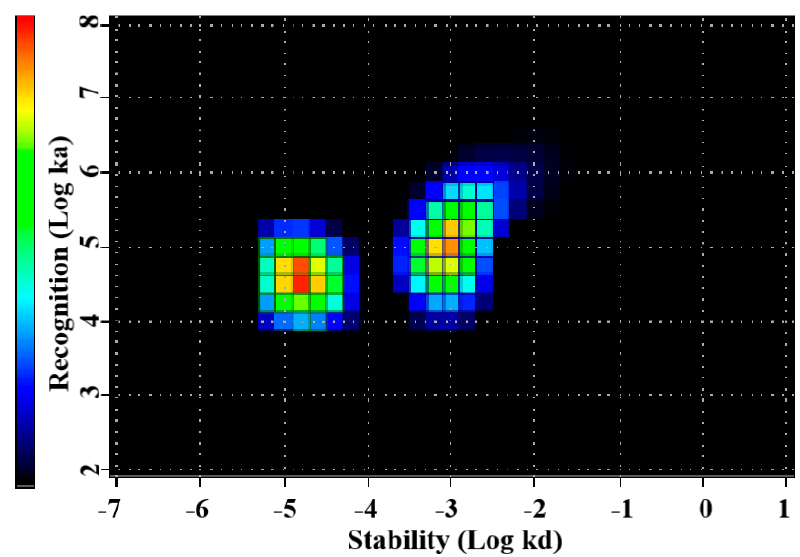
Figure 5. InteractionMap of [ 177 Lu]Lu-PEP40233 binding to HER2-expressing SKOV-3 cells in the presence of HSA. Binding was measured at concentrations of 0.25 nM, 0.75 nM, and 2.25 nM. Data are representatives from duplicates. The data show presence of two types of interactions with living HER2-expressing cells. Table 2. InteractionMap evaluation of the affinity of 177 Lu labeled PEP40233 binding to HER2-ex- pressing SKOV-3 cells in the presence of HSA.